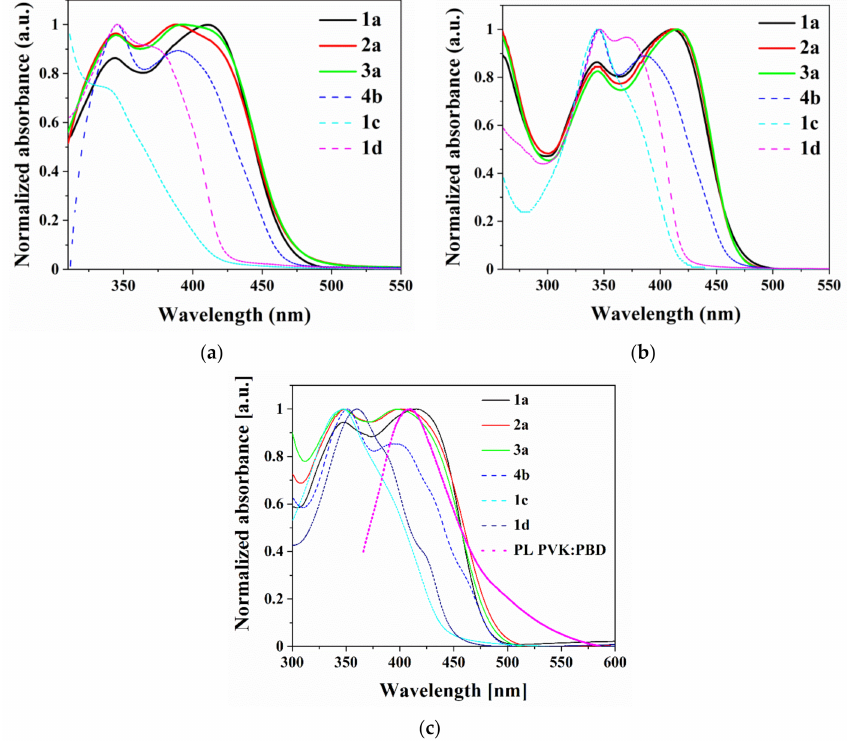
Figure 4. Absorption spectra of bis-(imino-1,8-naphthalimide) derivatives in ( a ) N-methyl-2- pyrrolidone; ( b ) chloroform, and ( c ) film together with PL spectrum of PVK:PBD. Bis-(imino-1,8-naphthalimide) in chloroform and NMP solutions were absorbed elec- tromagnetic radiation with λ max in the range 243–415 nm (5.10–2.99 eV). The